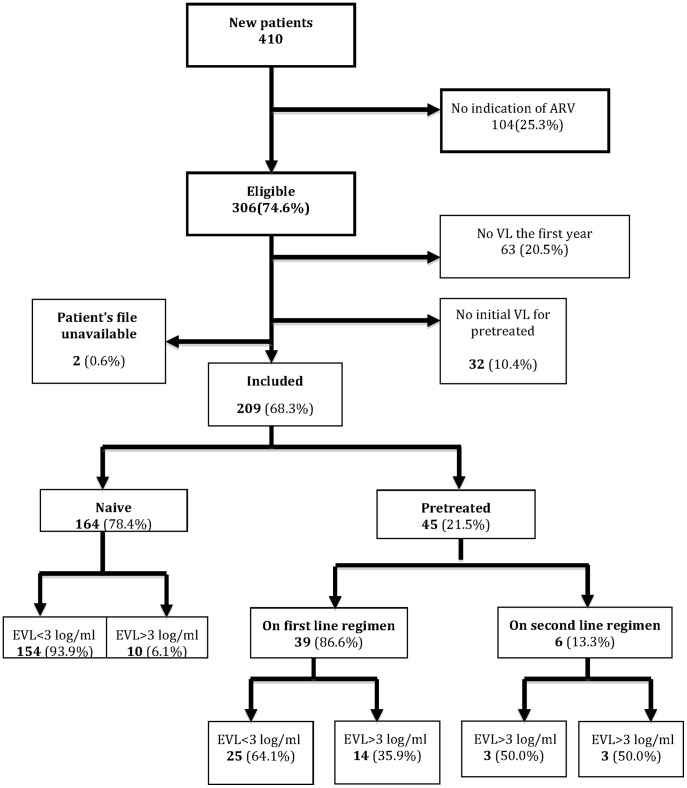
Flow chart of patients enrolled in early viral load study in Calmette hospital.